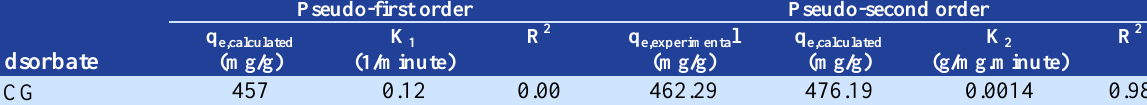
Table 1. Parameters of pseudo-first order and pseudo-second order kinetic models in this study Pseudo-first order Adsorbate